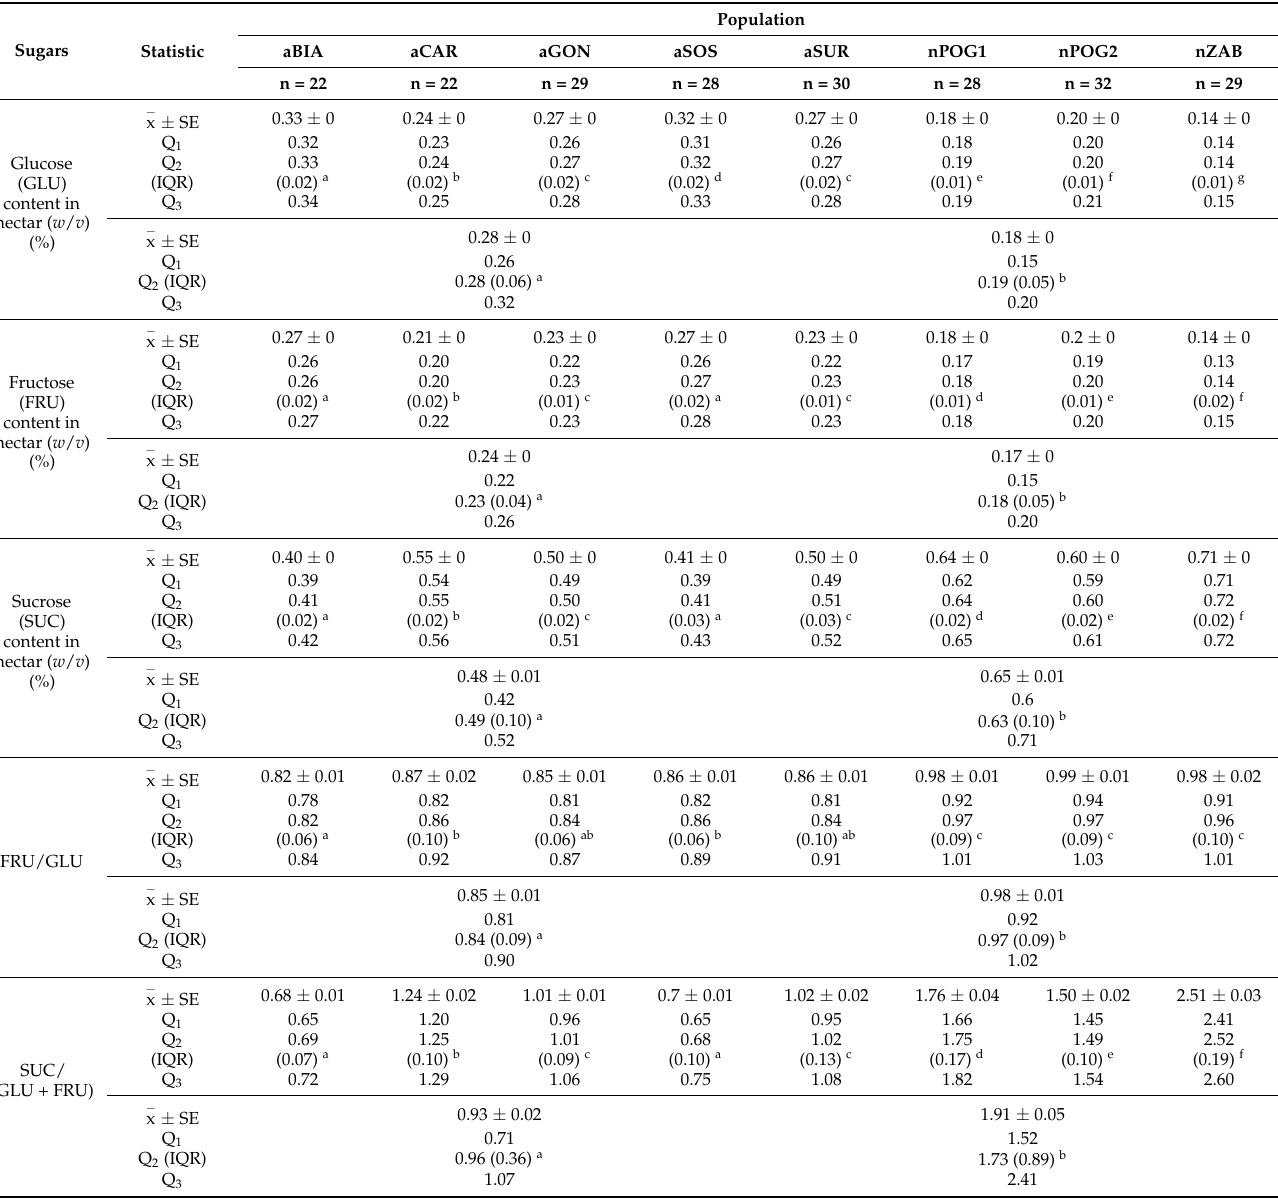
Table 3. The percentage content of sugars and their ratios in Epipactis helleborine nectar. Data represent the mean (x) ± standard error (SE), lower quartile (Q 1 ), median (Q 2 ), upper quartile (Q 3 ), interquartile range (IQR), and biological replicate (n). Different letters indicate statistically significant differences according to the pairwise Wilcoxon rank sum test with the Benjamini–Hochberg adjustment ( p <